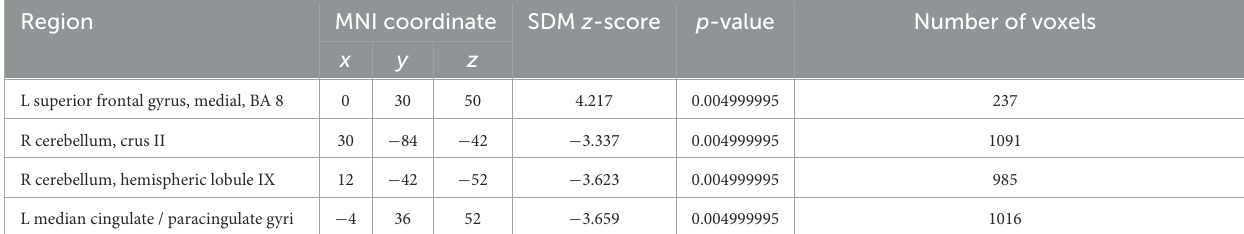
TABLE 7 Meta-regression analysis of head frequency in treatment group. Region